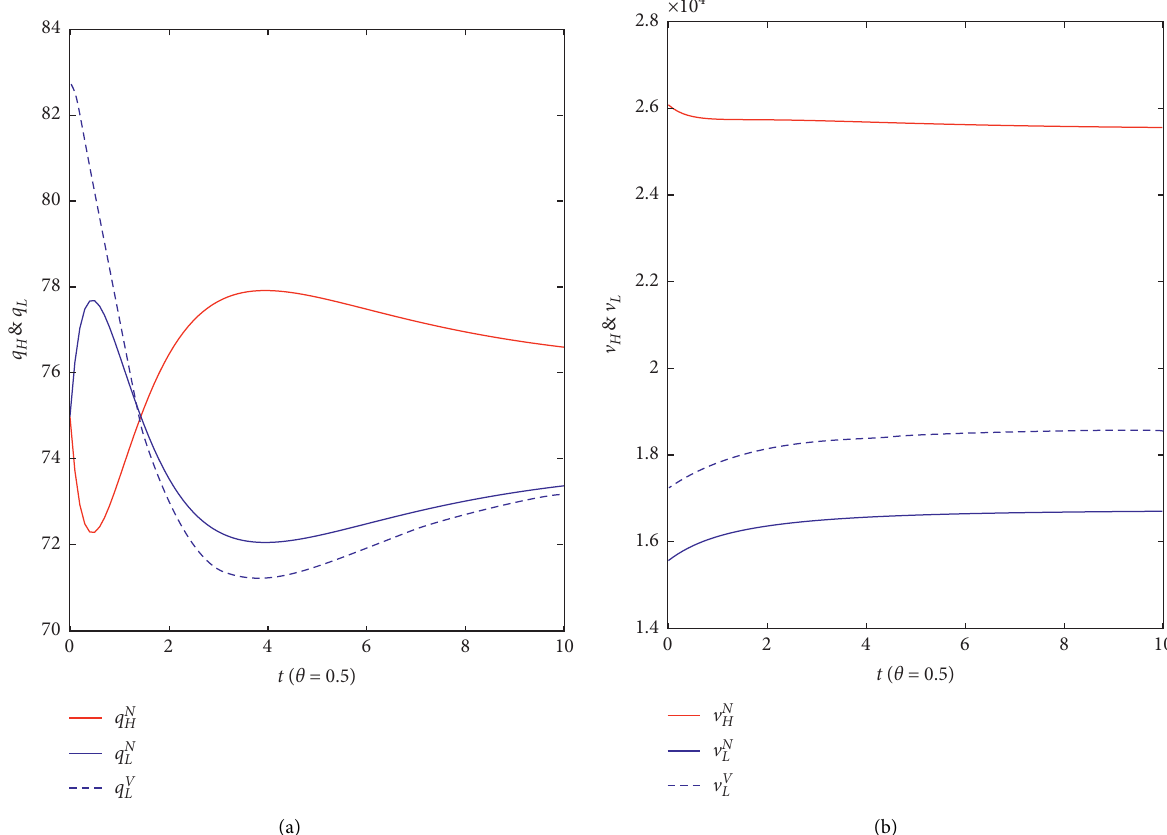
Figure 4: (a) Comparison of dynamic sales of the free-riding manufacturer and the green manufacturer under different modes ( θ � 0.5). (b) Comparison of dynamic profits of the free-riding manufacturer and the green manufacturer under different modes ( θ �